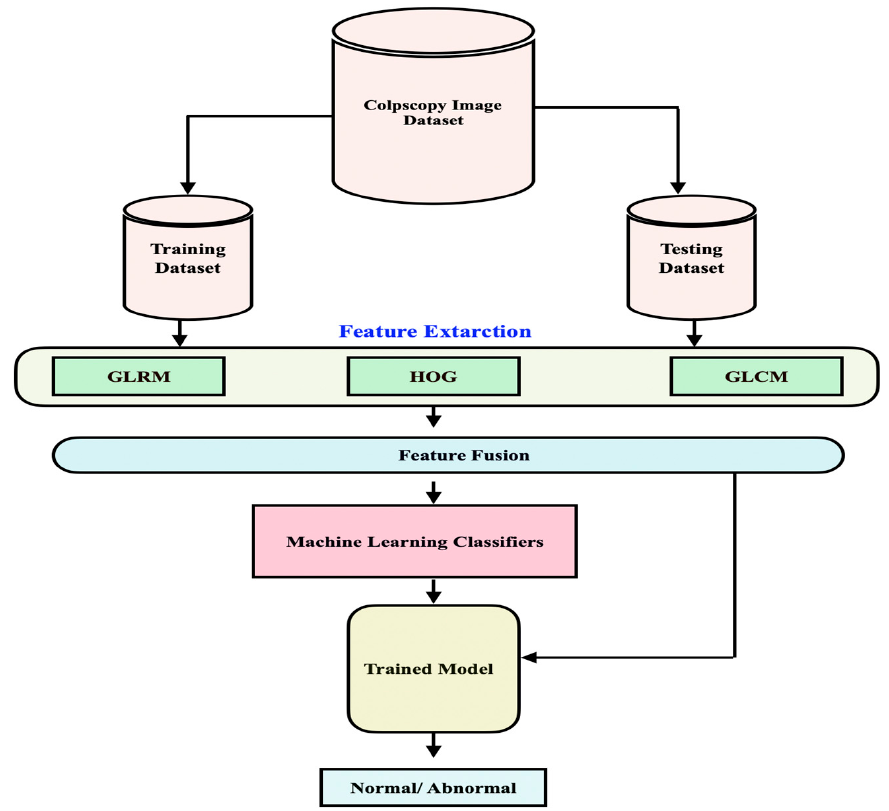
Figure 1. ColpoClassifier: proposed hybrid framework for classification of cervigrams.